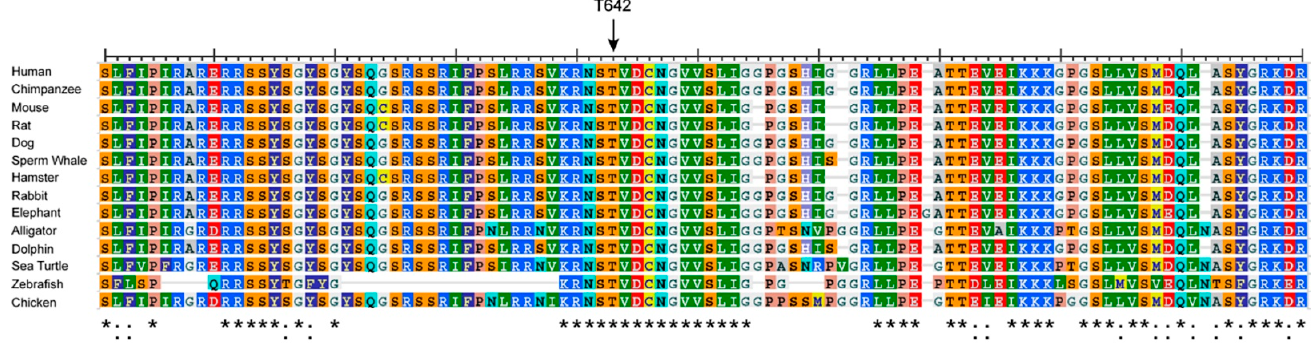
Figure 3. Nav1.6 protein sequence alignments of L1 region spanning amino acids 600–696 (human SCN8A ) compared to other Nav1.6 orthologs. T642 is denoted by the arrow. An * (asterisk) indicates a fully conserved amino acid residue. A: (colon) indicates conversation of amino acid residues with similar properties.